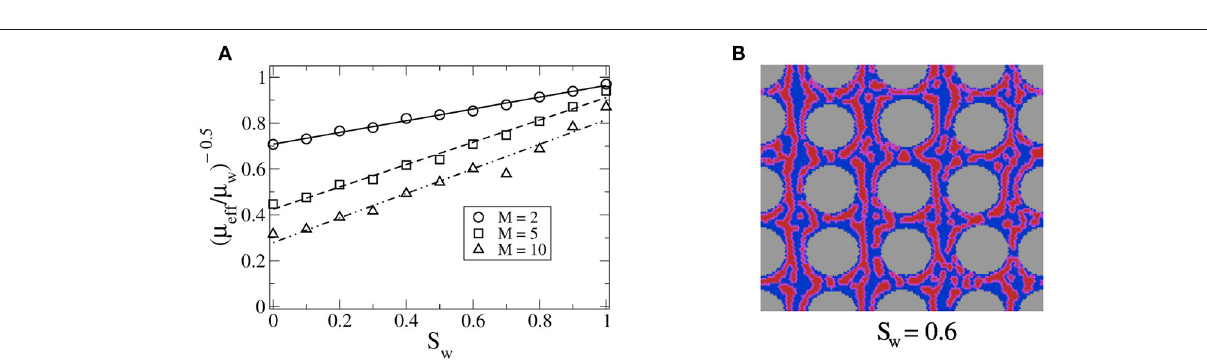
FIGURE 6 | (A) Plot of ( µ eff /µ w ) α from lattice Boltzmann simulations with less viscous wetting fluid where we find α lubrication layers of less viscous blue fluid as seen in (B) . The end points close to S w Reynolds numbers, an effect that is likely to increase with increasing M the way the simulations are